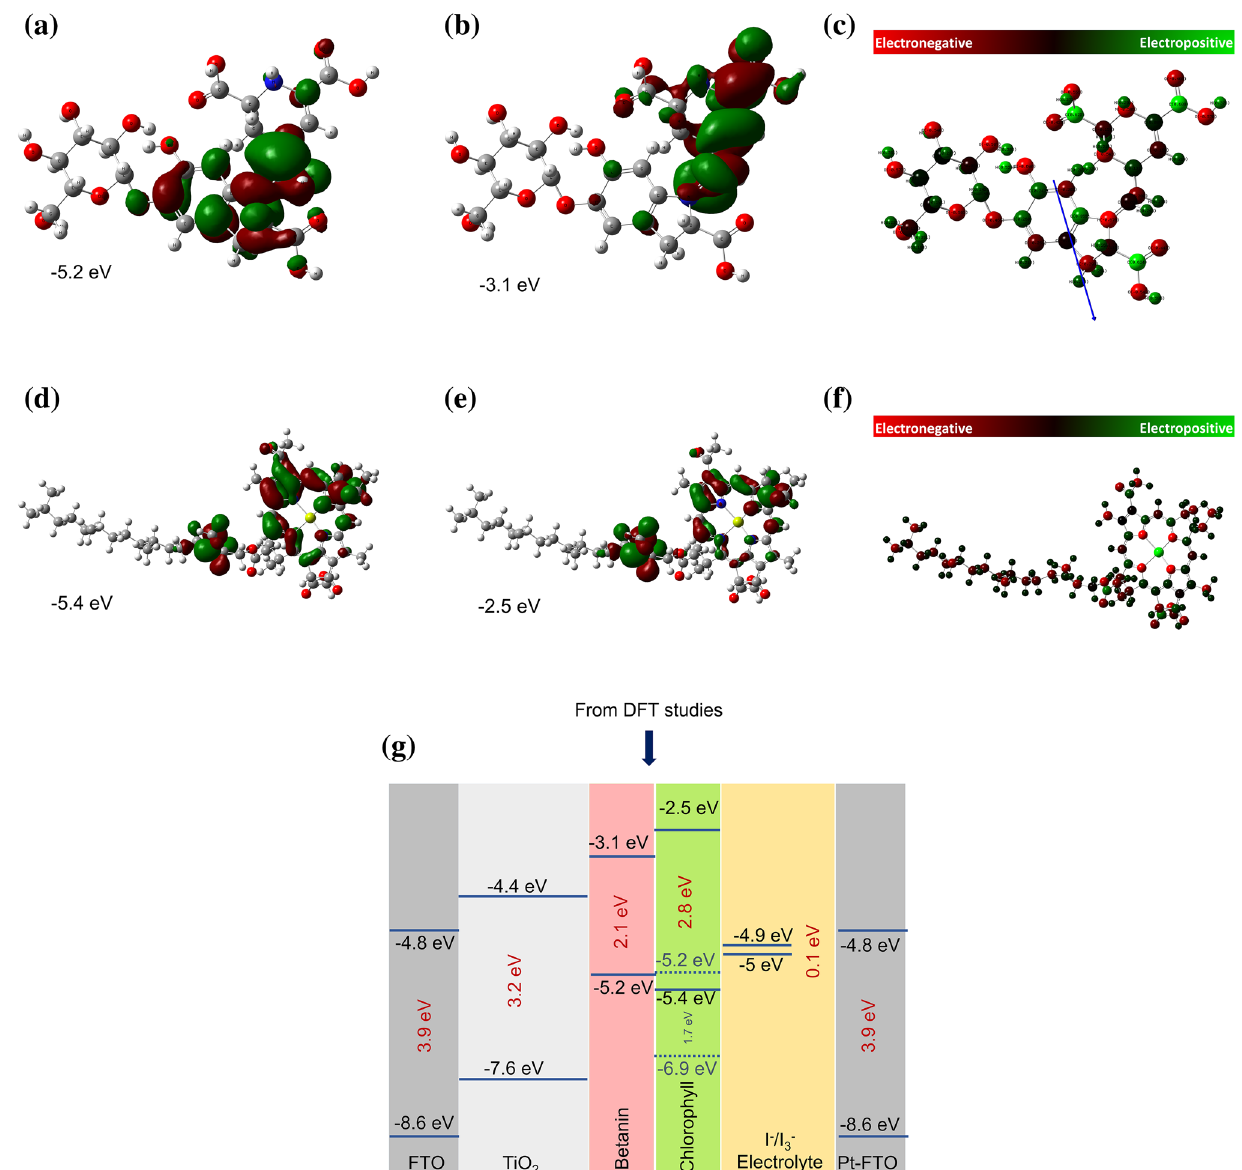
Fig. 3 Electron density corresponding to the a HOMO energy level of betanin b and the LUMO energy level of betanin. c The charge distri- bution on the betanin molecule. Electron density corresponding to the d HOMO energy level of chlorophyll e and the LUMO energy level